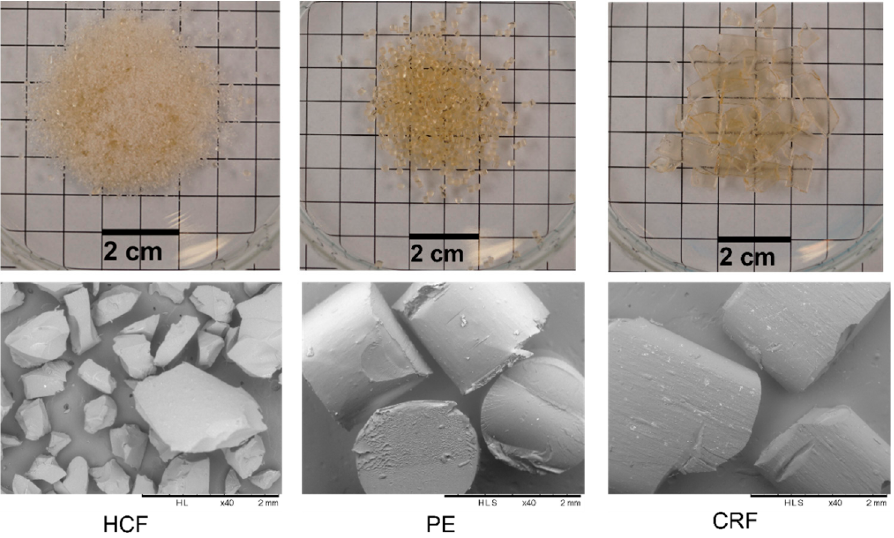
Figure 3. Photograph ( top ) and SEM micrograph ( bottom ) of different feedstocks for milling. From left to right: HCF, PE, CRF.